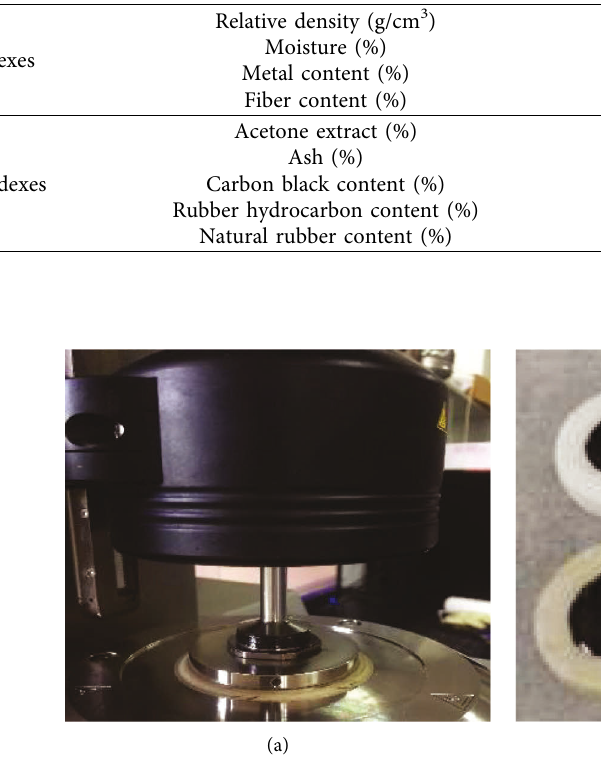
Figure 2: Frequency sweep test: (a) DSR equipment and (b) asphalt